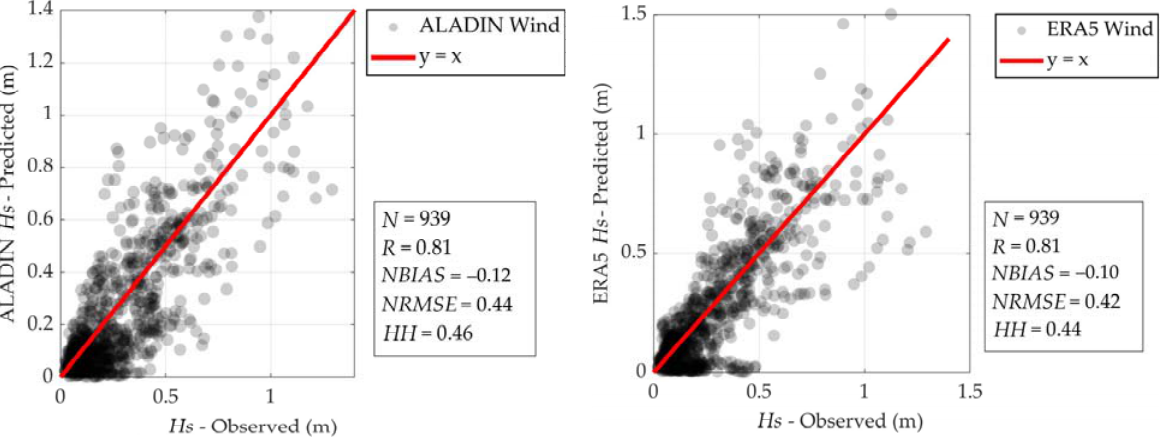
Figure 8. Scatter diagrams and performance metrics showing the consistency between the simulated significant wave heights (forced by ERA5 wind ( left ) with C ds = 1.2 and ALADIN ( right ) with C ds = 0.3) and measured significant wave heights for the calibrated period (XX).